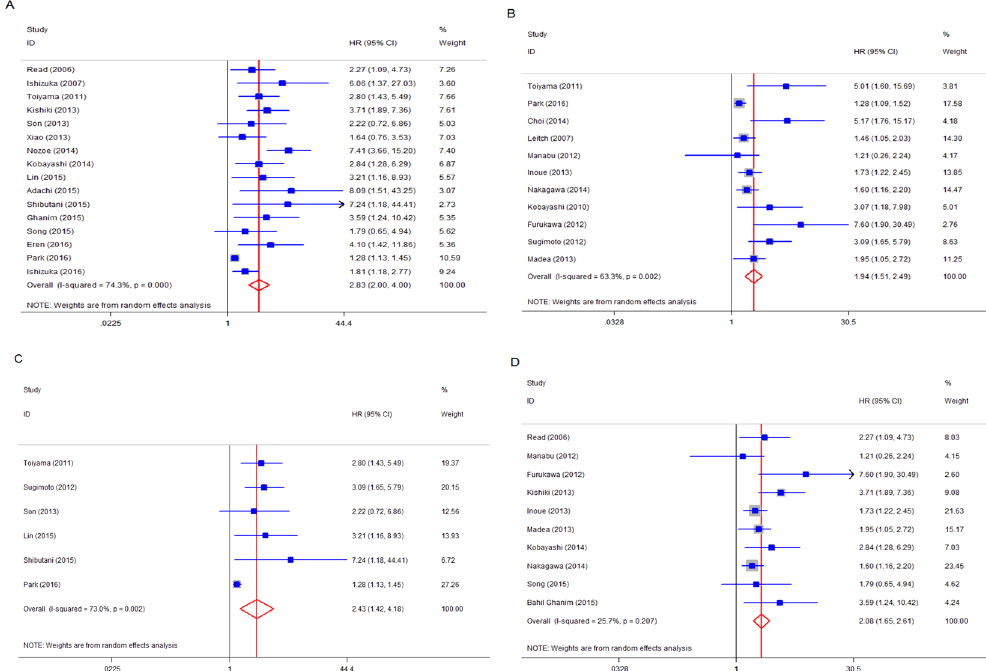
Figure 2. ( A ) Forest plot of hazard ratio for the association between GPS and OS in patients with CRC; ( B ) Forest plot of hazard ratio for the association betweenGPS and CSS; ( C ) Forest plot of hazard ratio for the association between elevated GPS and survival in patients with primary operable disease; ( D ) Forest plot of hazard ratio for the association between elevated GPS and survival in patients with advanced inoperable